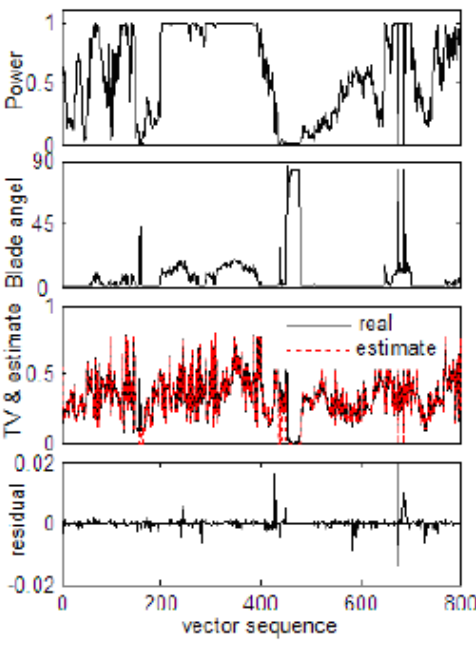
Figure 5. Validation for sub-model